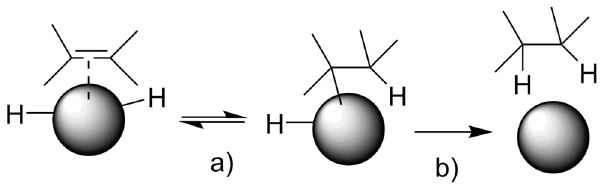
Figure 9. Mechanism of the heterogeneously catalysed hydrogenation of C=C bond.